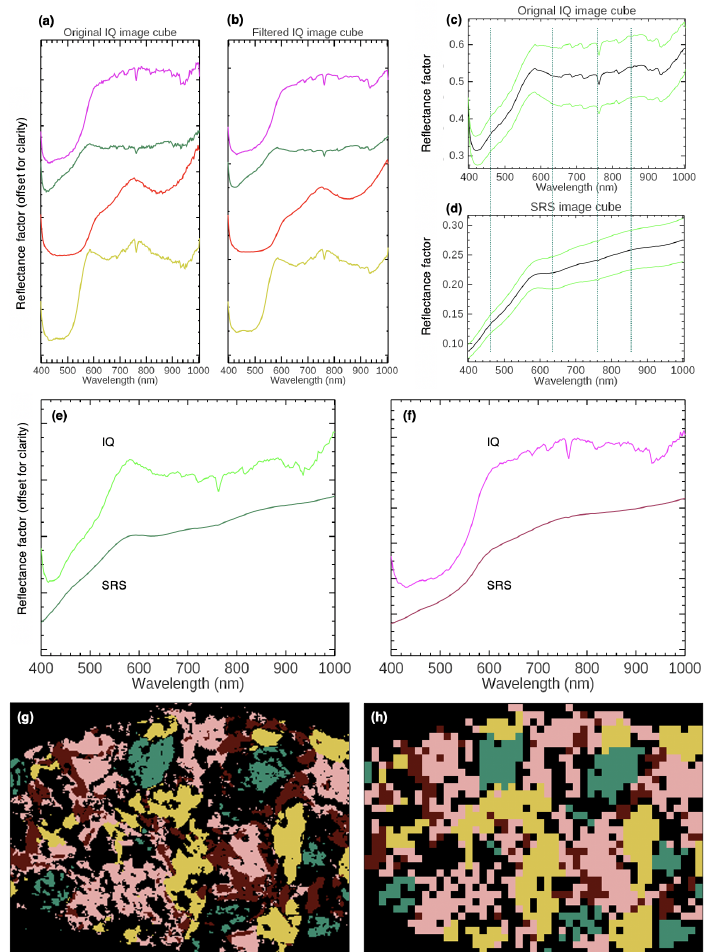
Figure 9. ( a ) The reflectance endmembers associated with those obtained from spectral analysis of the first derivative of the reflectance image cube of Imitation marble collected with the IQ hyperspectral camera. These endmembers are color-coded to match those obtained from analysis of the SRS image cube to allow comparison (see Figure 6b). ( b ) The four reflectance endmembers from ( a ) after filtering using an MNF transform on the cube. ( c ) An ROI was selected from the blue-green paint in the unfiltered IQ image cube from which the mean reflectance spectrum (the black curve) and the standard deviation (the green curves) were calculated. ( d ) An ROI was selected from the same region in the SRS image cube; the mean reflectance spectrum (the black curve) ± the standard deviation (the green curves) are plotted here for comparison. ( e , f ) compare the SRS image cube and IQ image cube reflectance endmembers for the blue-green and pink paint endmembers, respectively. ( g ) The IQ SAM map showing the distribution of the first derivative-cube extracted endmembers. ( h ) The SRS SAM map showing the distribution of the first derivative-extracted